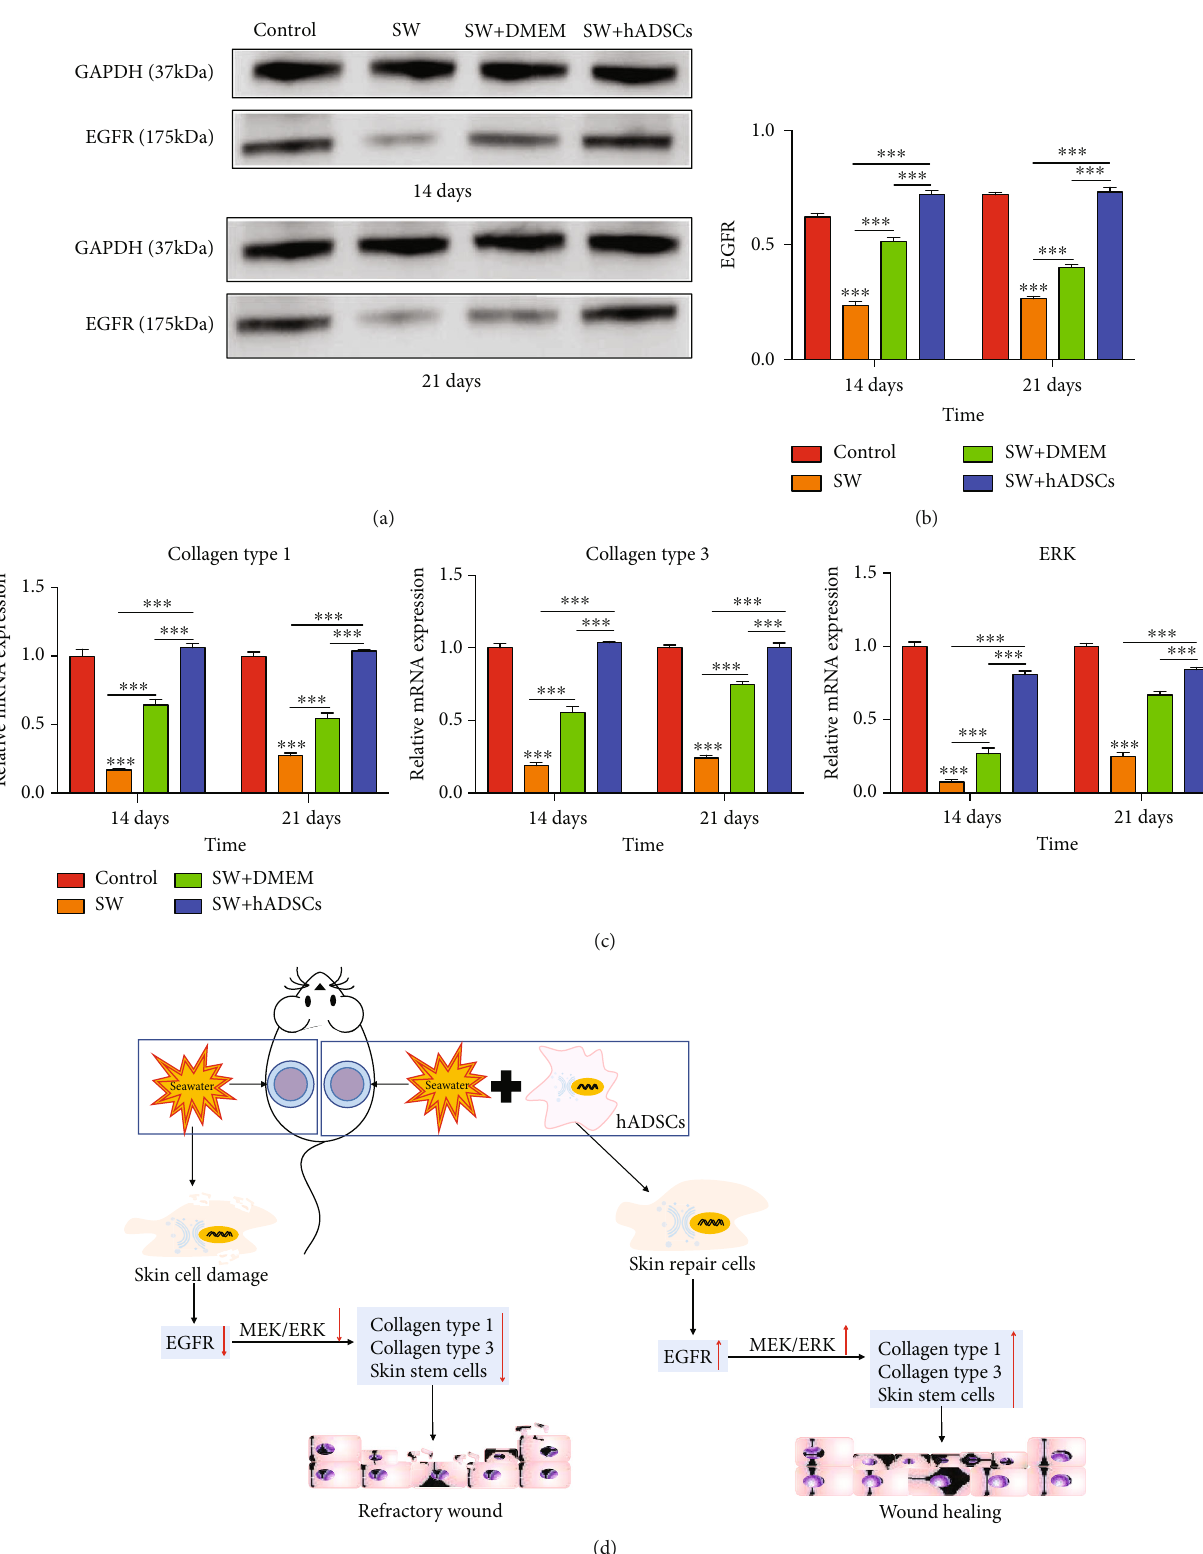
Figure 6: hADSCs a ff ect MEK/ERK signaling pathway activation in SW-treated wounds. The expression levels of EGF protein (a, b) and collagen type 1, collagen type 3, and ERK mRNA levels (c) in the control group and the SW+hADSC group were signi fi cantly higher than those in the SW group and the SW+DMEM group. A schematic diagram shows how SW and hADSCs regulate wound healing through the MEK/ERK signaling pathway (d). ∗ P < 0 : 05 , ∗∗ P < 0 : 01 , and ∗∗∗ P < 0 : 001